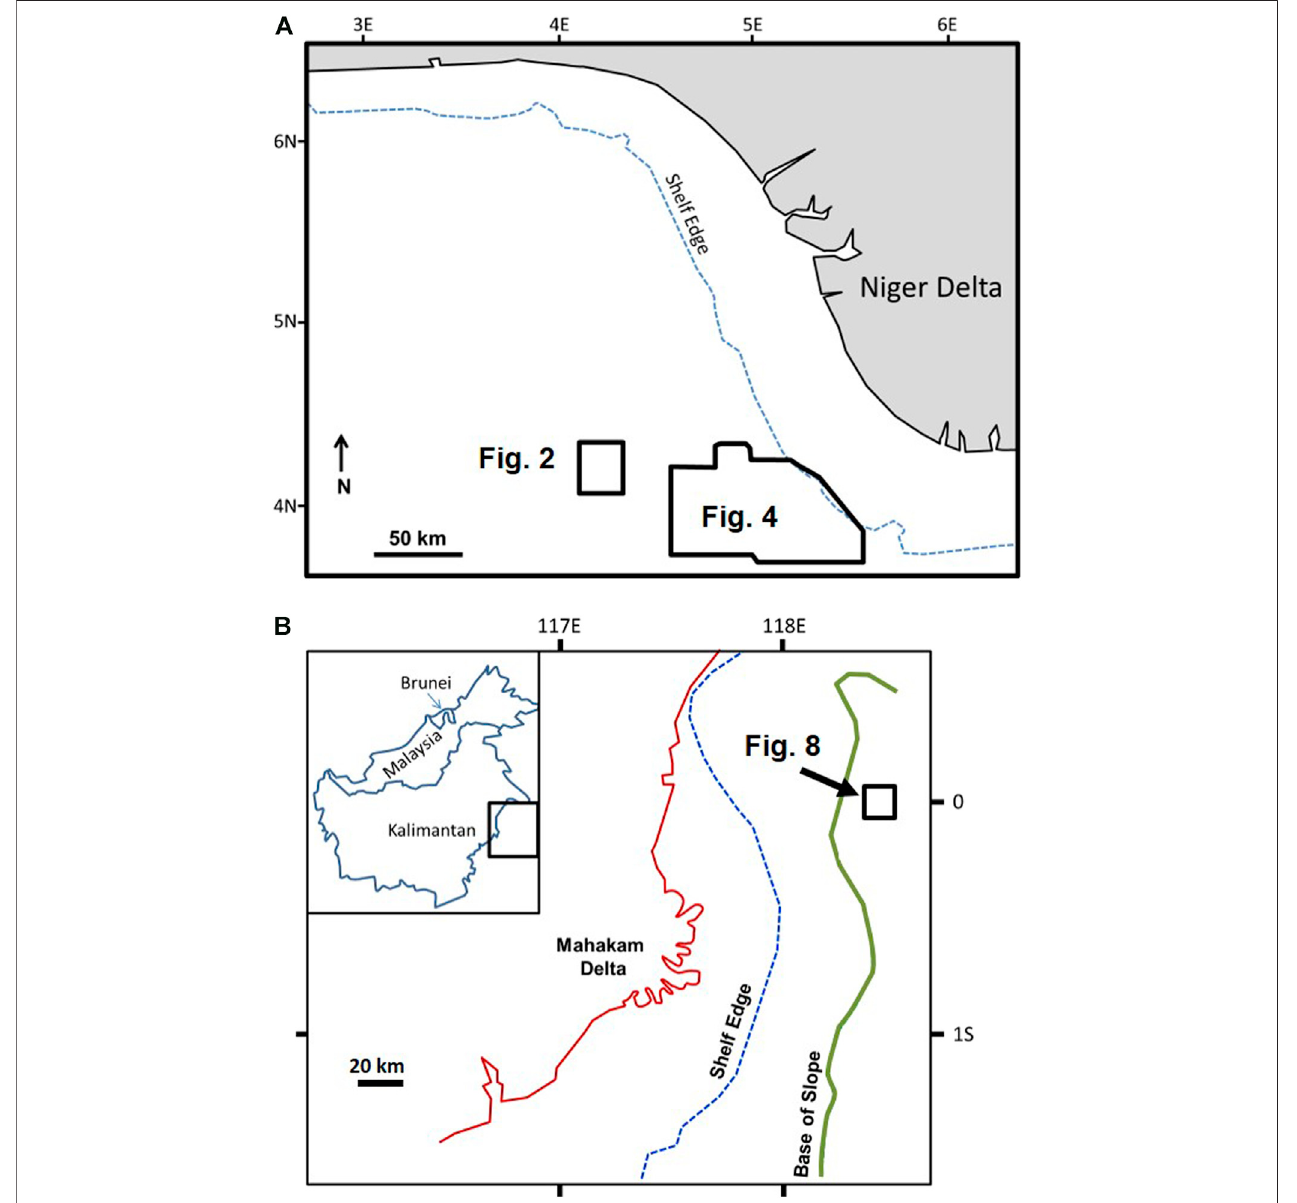
FIGURE1|(A) mapofaportionofoffshoreNigeria.Thelocationofpanels2,4areindicated. (B) mapofaportionofoffshoreKalimantan,Indonesia.Thelocationof panel 8 is indicated.